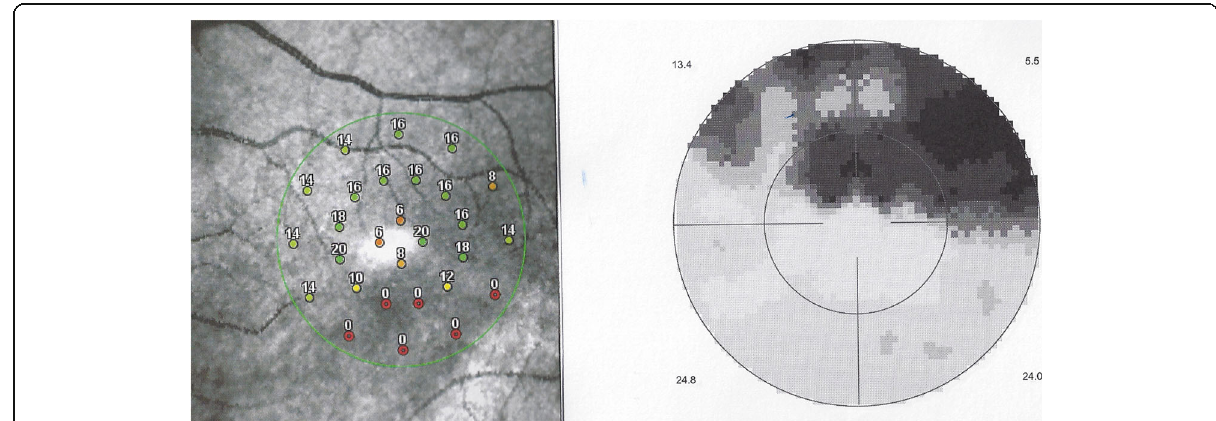
Fig. 15 Visual field and microperimetry 6 months after the acute episode, showing improved microperimetry score (left) and slight reduction of scotoma (right) (case